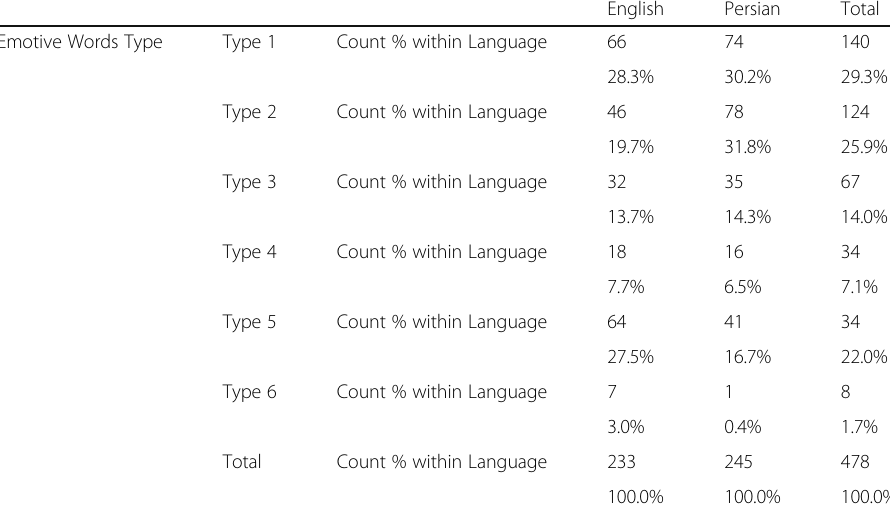
English Persian Total